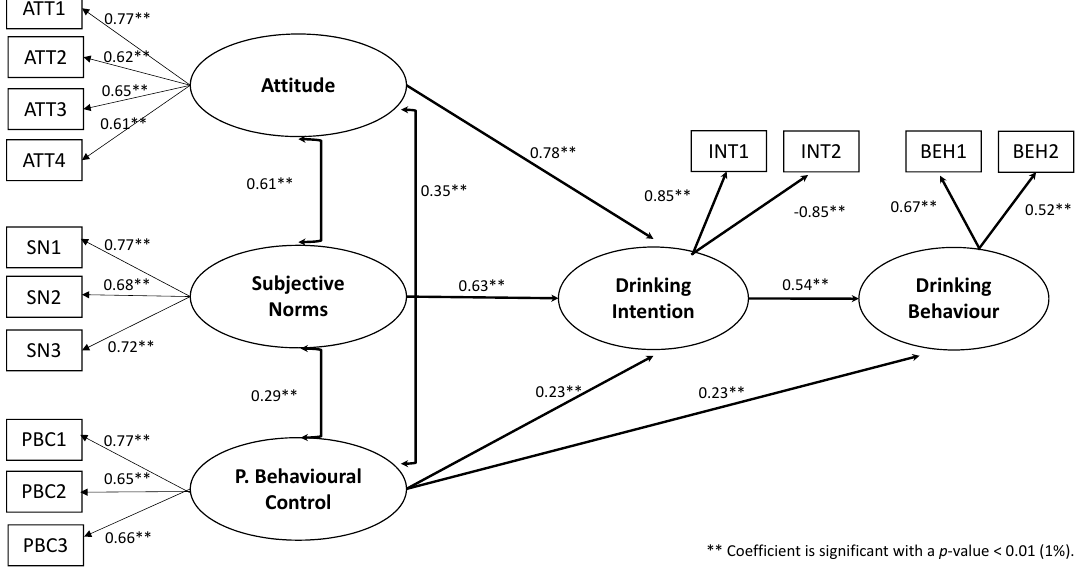
Figure 1. Results of the predictive